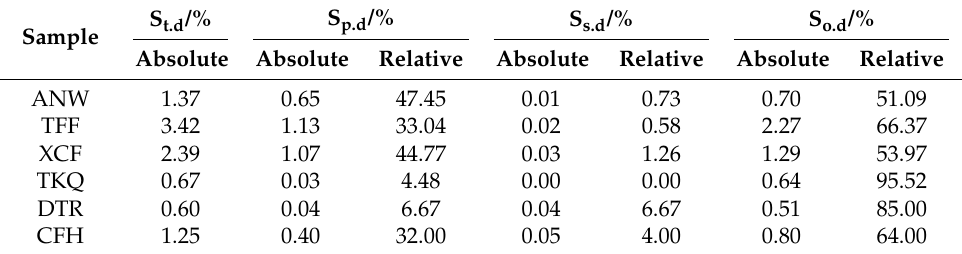
Table 6. The sulfur forms of six coal